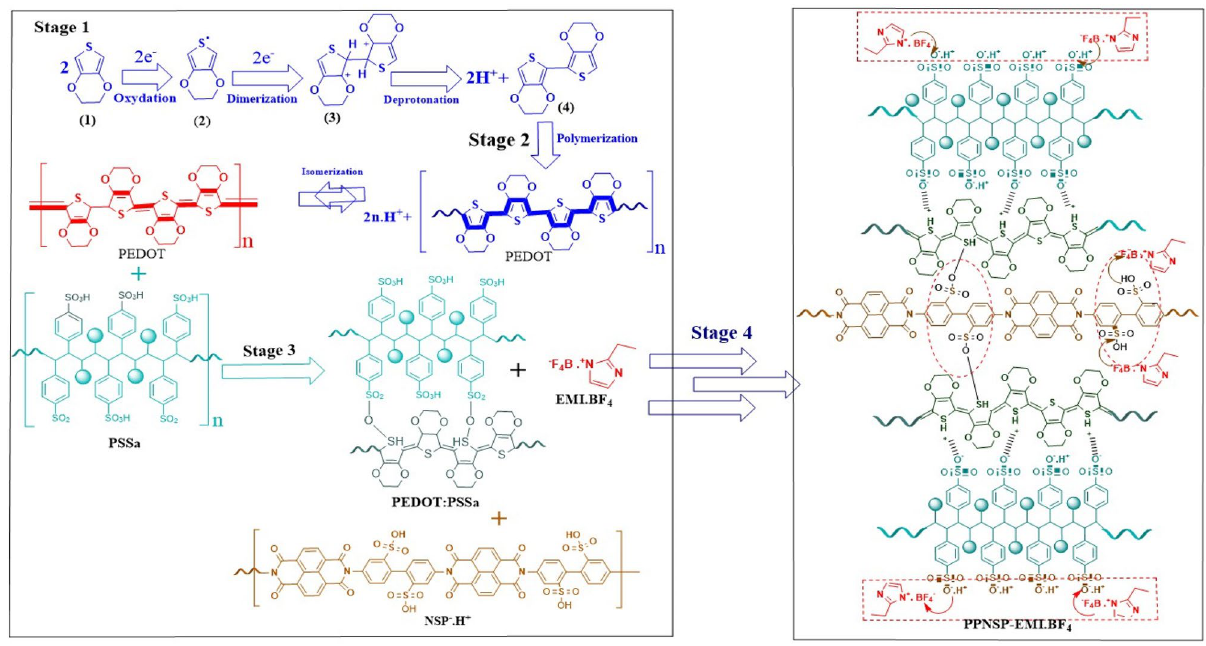
Figure 3. Mechanistic approach of the formation of oxidative and dimerization of EDOT, stage 1; polymerization and isomerization of EDOT, stage 2; Ionic interactions of EMI.BF 4 with NSP - . H + , and PEDOT: PSSa, stage-3; and ion hopping mechanism between PPNSP and EMI.BF 4 , stage various applied frequencies. The working principle of the proposed PPNSP-EMI.BF 4 e-skin TENG was explained by the PPNSP surface, and the aluminum (Al) electrodes were initially free of charges, as shown in Fig. 5c. When